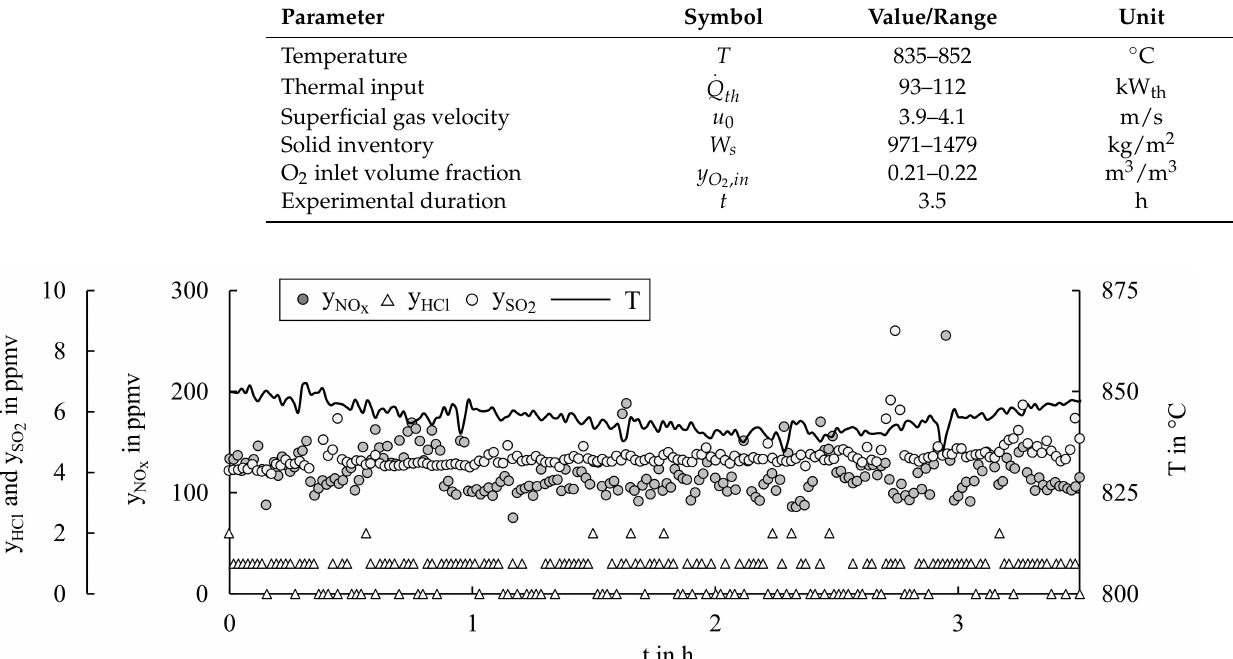
Figure 8. Volume fractions of NO x ( y NO recovered fuel mono-combustion. y NO measured by Fourier-transform infrared